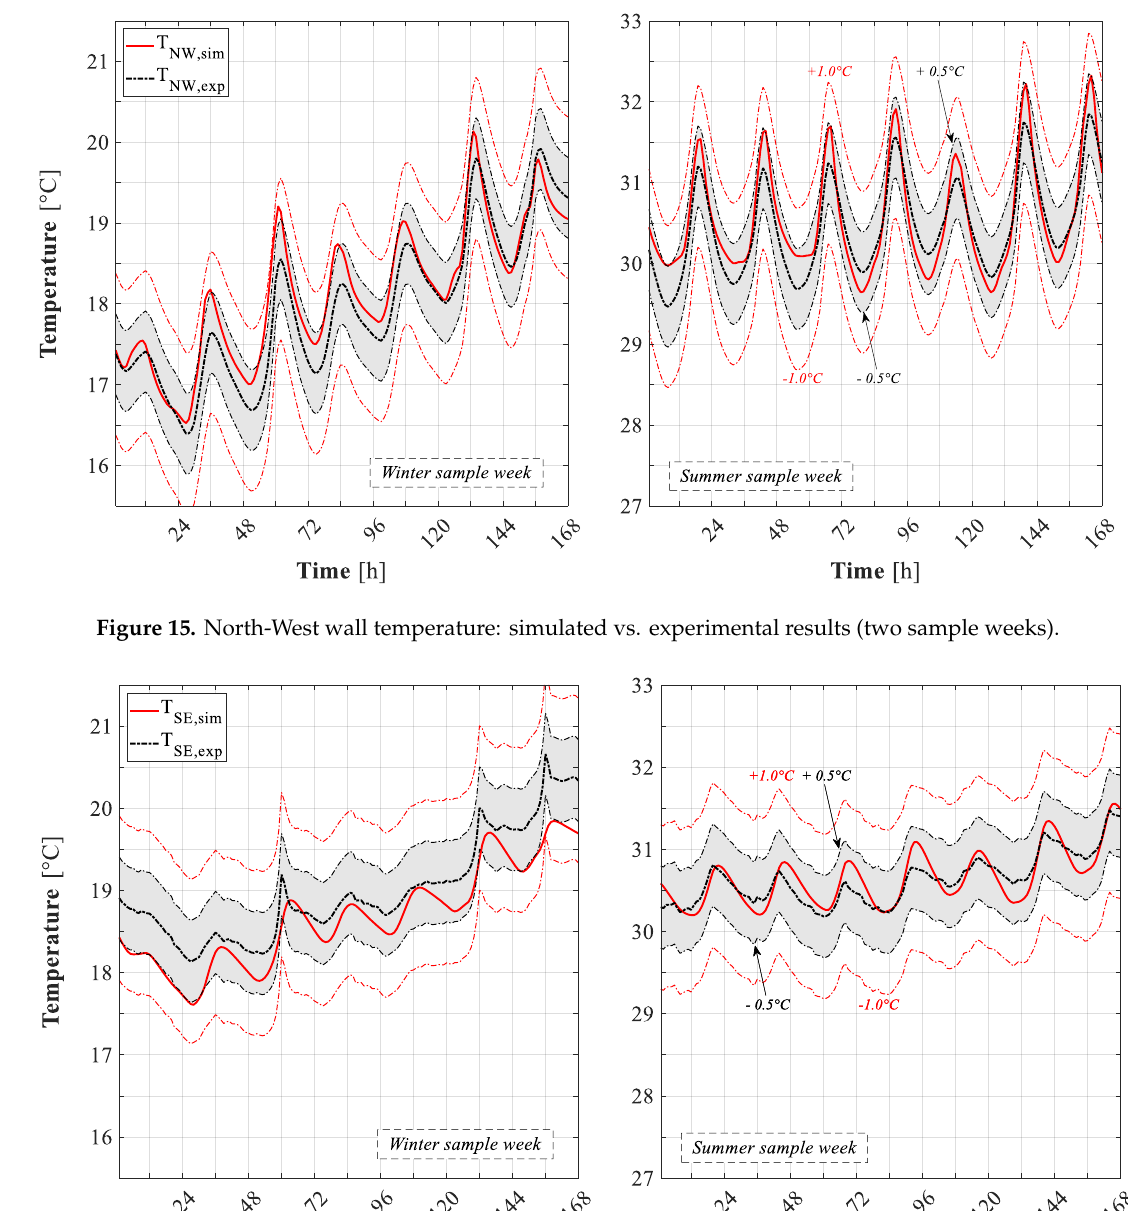
Figure 14. South-West wall temperature: simulated vs. experimental results (two sample weeks).